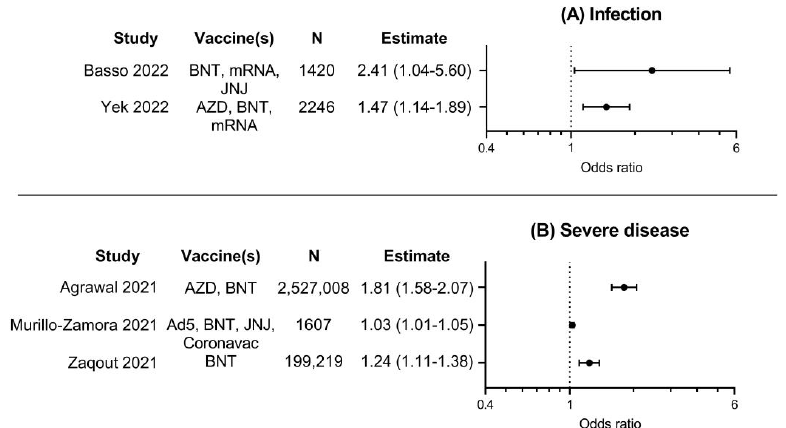
Figure 3. Forest plots with point estimates and 95% confidence intervals of odds ratios for A. infection with COVID-19, or B. severe COVID-19 for vaccinated persons with diabetes, compared to vaccinated persons without diabetes. N denotes total number of participants per study, as numbers per group were usually not available. Ad5, Ad5-nCoV-S (CanSino); AZD, AZD-1222 (AstraZeneca); BNT, BNT162b2 (Pfizer); JNJ, JNJ-78436735 (Janssen); mRNA, mRNA-1273 (Moderna).